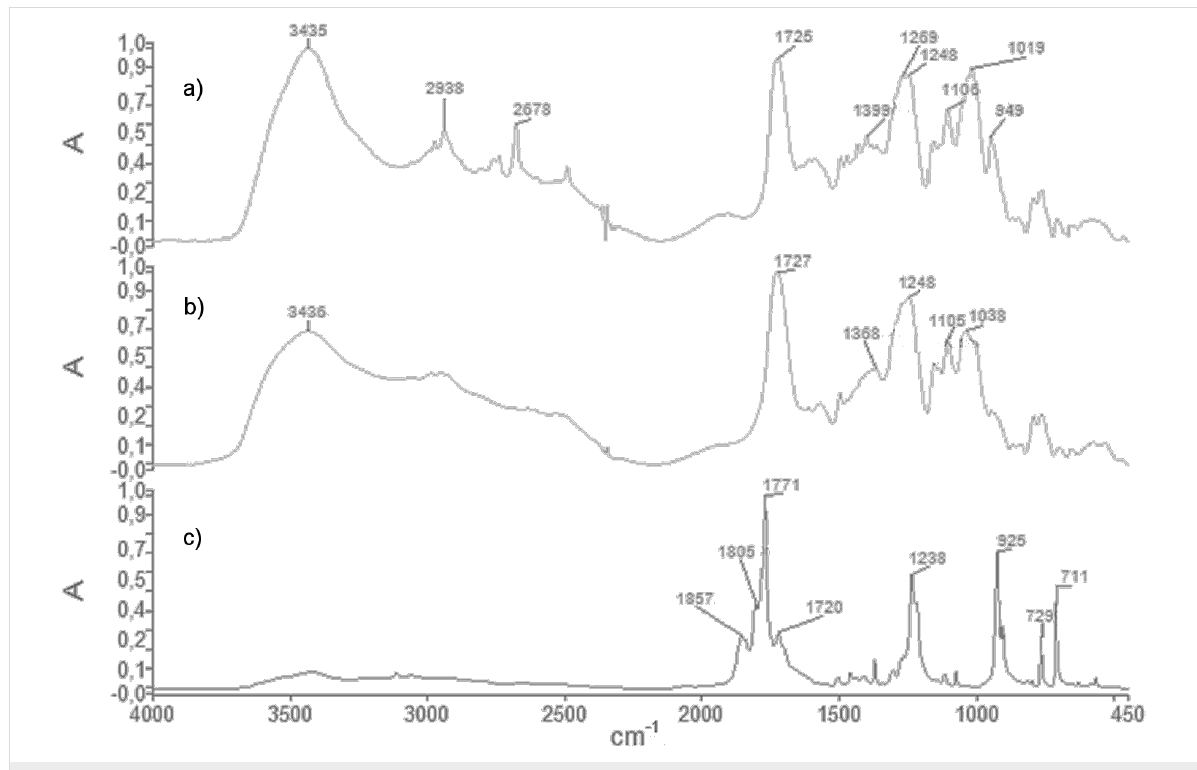
Figure 1: FTIR spectra of branched β -CD polymer (a), cross-linked β -CD nanosponge (b) and pyromellitic dianhydride